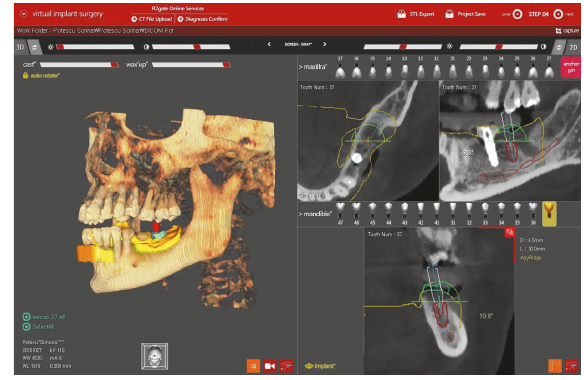
Figure 1: Planned implant insertion in R2GATE (cid:2)